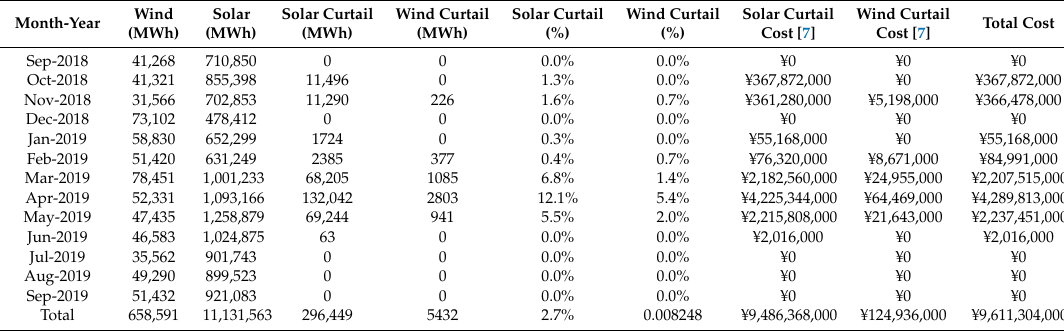
Table 2. Monthly VRE generation and curtailment in MWh and curtailment cost.